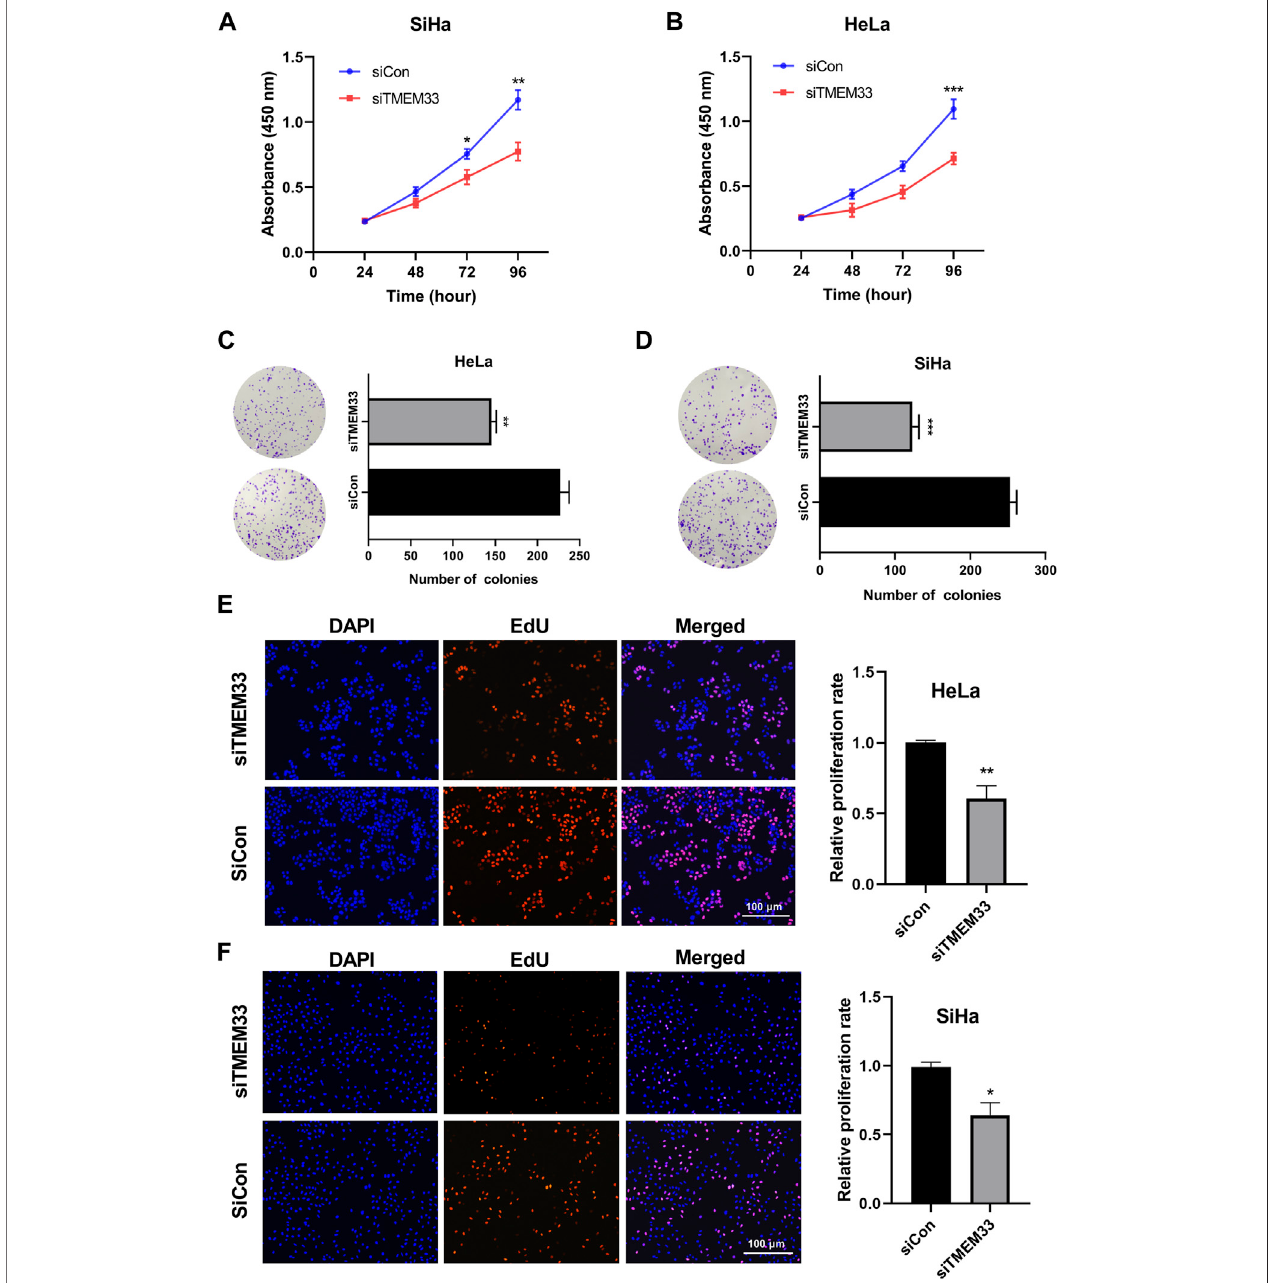
FIGURE 7 | TMEM33 promotes cell proliferation in cervical cancer. (A,B) CCK-8 assay of HeLa and SiHa cells transfected with TMEM33 siRNA. (C,D) Colony formation assay of HeLa and SiHa cells transfected with TMEM33 siRNA. (E,F) DNA synthesis determined by EdU incorporation assay after cell transfection with TMEM33 siRNA in HeLa and SiHa cells (EdU% represents the proportion of EdU-positive cells [orange]). Data are mean ± SD of three independent experiments * p < 0.05, ** p < 0.01, and *** p < 0.001.